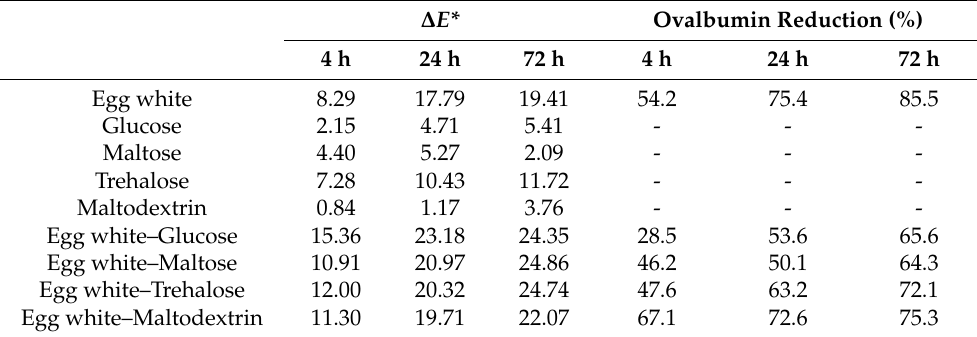
For ∆ E* values: DS < 0.05. For % of ovalbumina reduction: DS <